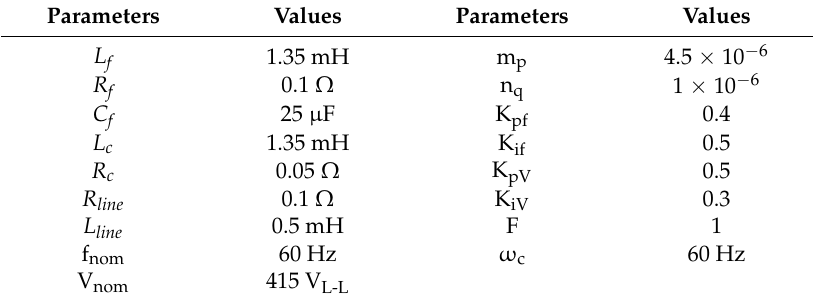
Table 1. System Parameters.